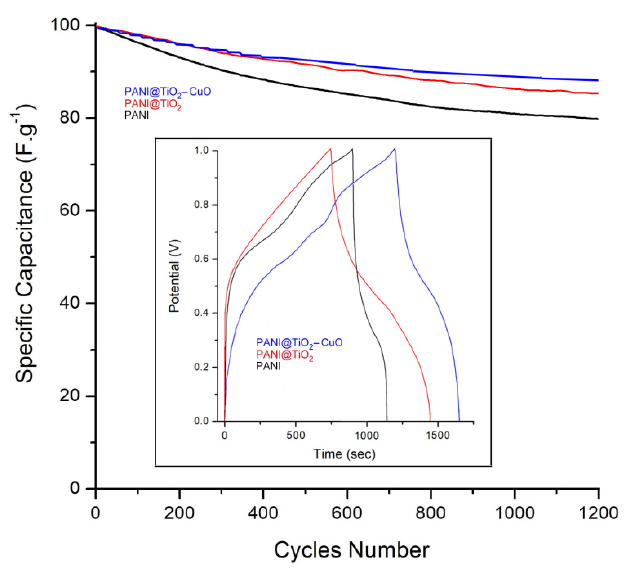
Figure 11. The cycling performance of PANI, PANI@TiO 2 and PANI@TiO 2 –CuO electrodes at a current density of 1 A g − 1 ; The inset demonstrates the comparative GCD curves of PANI, PANI@TiO 2 and PANI@TiO 2 –CuO at a current density of 1.0 mA.cm 2 .